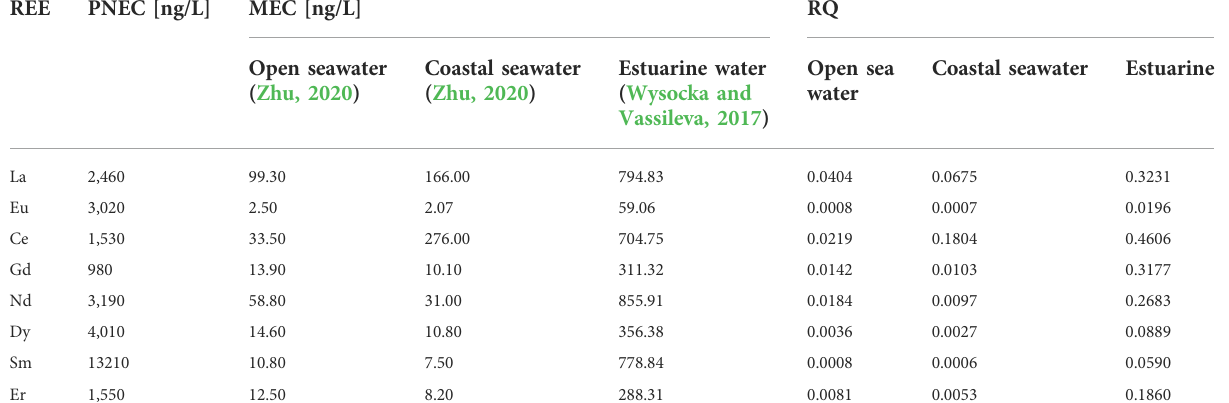
TABLE 3 Calculated risk quotients for REEs in